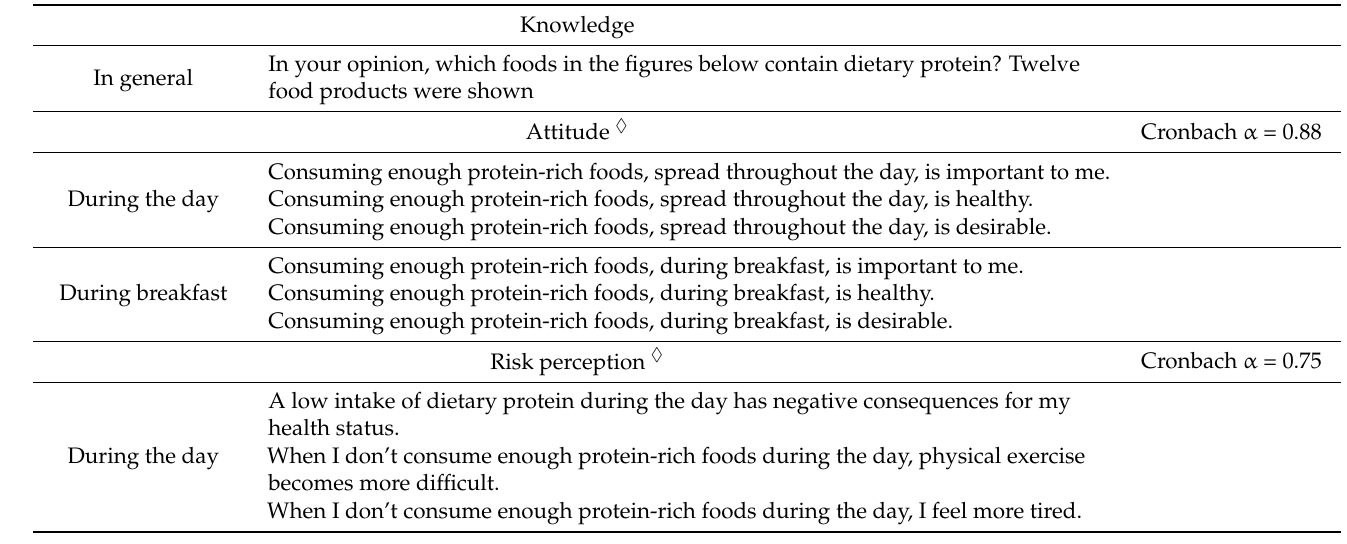
Table 1. Items in the questionnaire, presented per determinant of behavior and time of